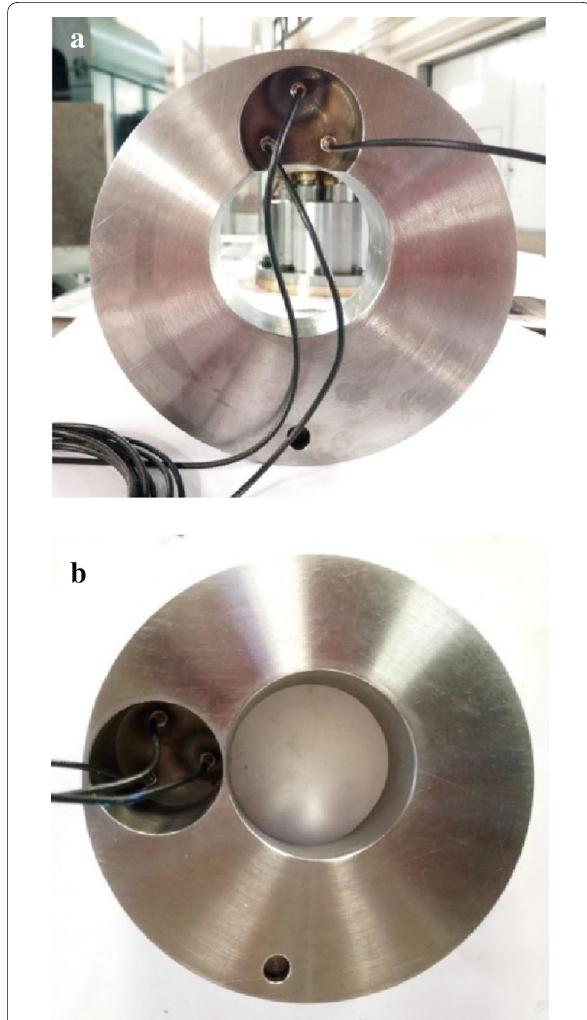
Figure 6 Photo of sensor mounting: (a) at TDC; (b) at the high or low pressure zone